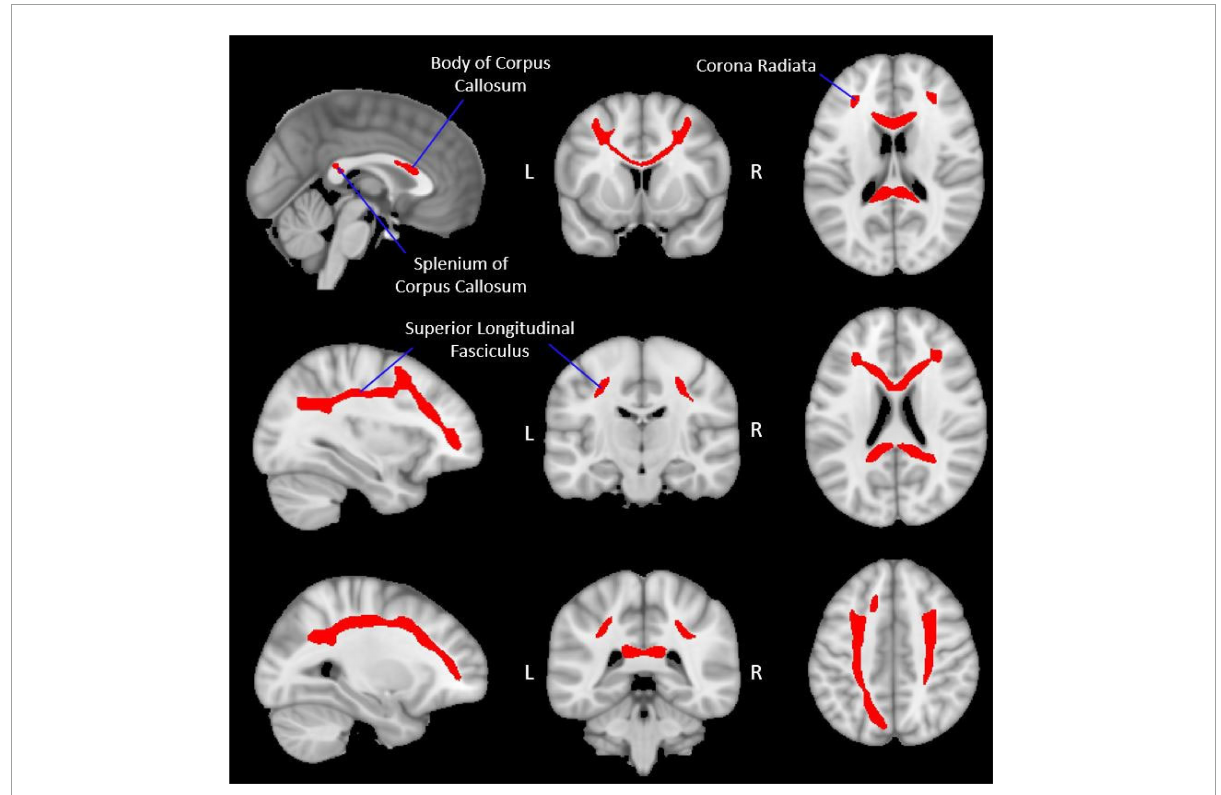
FIGURE2 Group-level working memory network white matter mask. The figure displays the group-level white matter tracts (red), identified via probabilistic tractography, which make up the WMN-WM mask (Section “Extracting diffusion metrics from the group WMN-WM mask”)